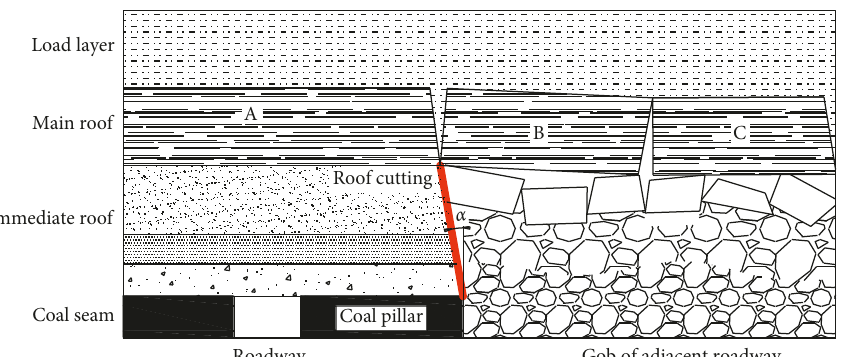
Figure 1: Structural model of the short-arm beam.